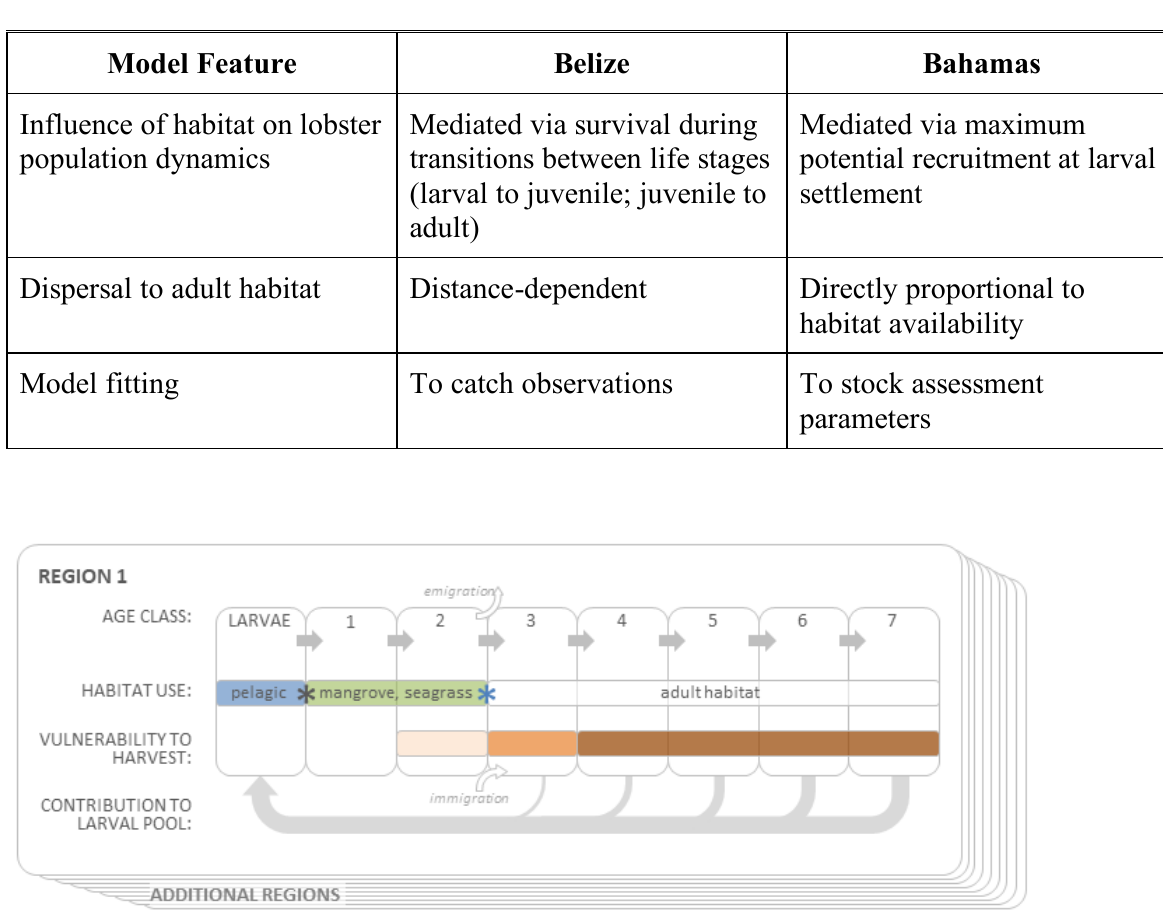
Table A1.1 Summary of differences in model features for lobster population dynamics in Belize and the Bahamas.